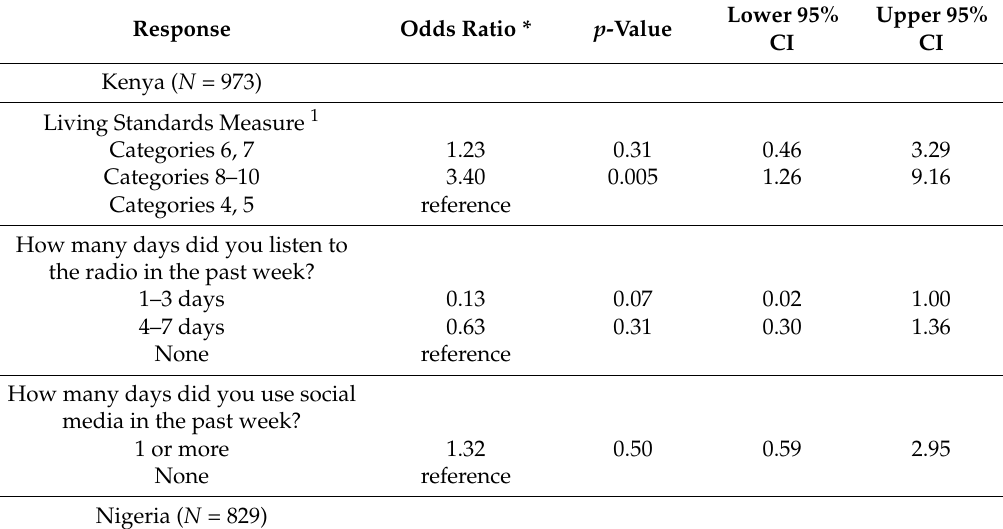
Table 7. Results from Multivariable Logistic Regression. OUTCOME 2: Kenya & Bangladesh: Have you ever owned a modern stove like these? (Visual Aid A). Nigeria: Have you ever owned an LPG